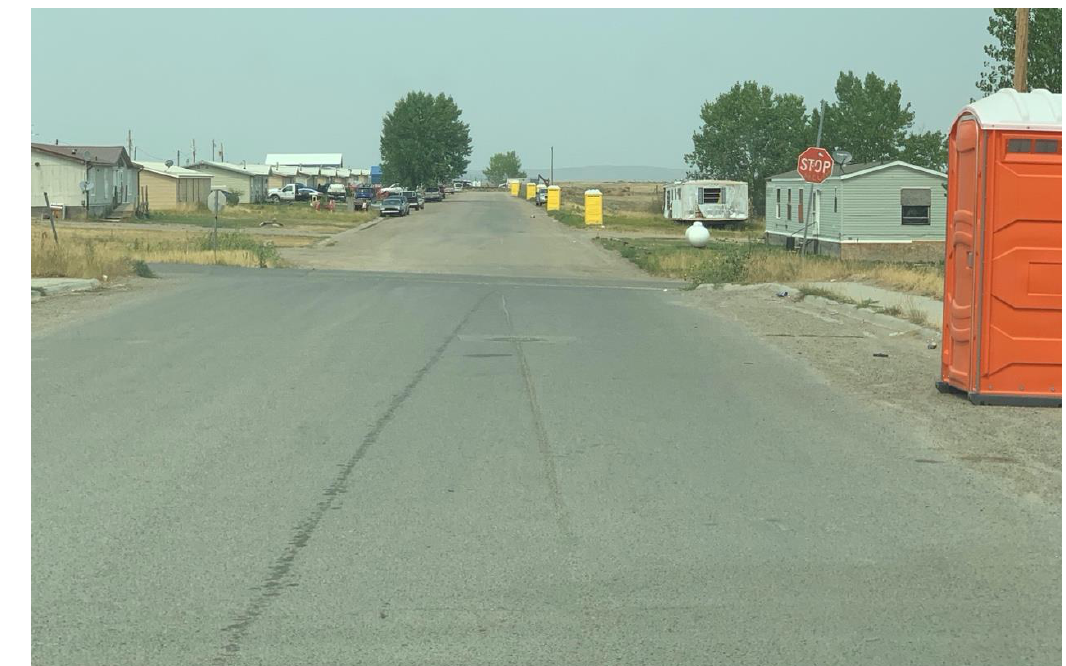
Figure 6. Portable toilets on the street for residents to use while water restrictions are in place for the town of Crow Agency, MT August 2020. Photo credit: Christine Martin.